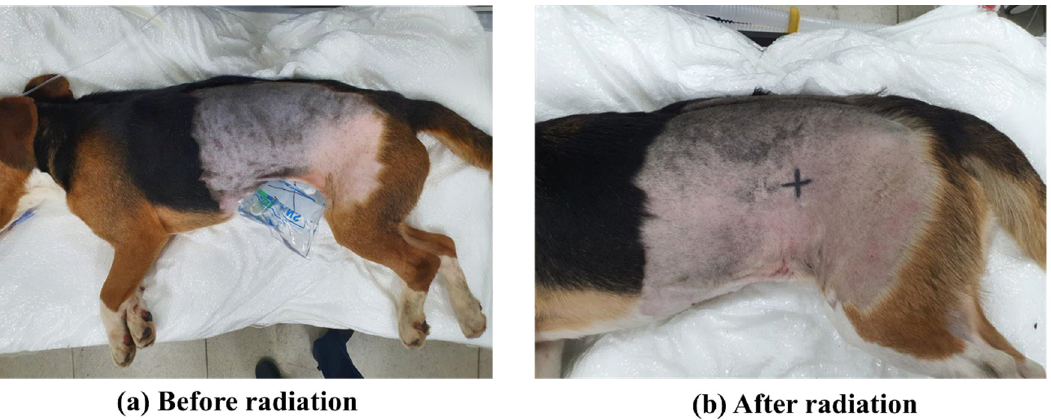
Figure 1. The healthy beagle received 12 fractions of 4 Gy for a total dose of 48 Gy daily for 12 days. After irradiation, the beagle’s skin was observed immediately. With the exception of slight erythema, the skin showed no significant difference.